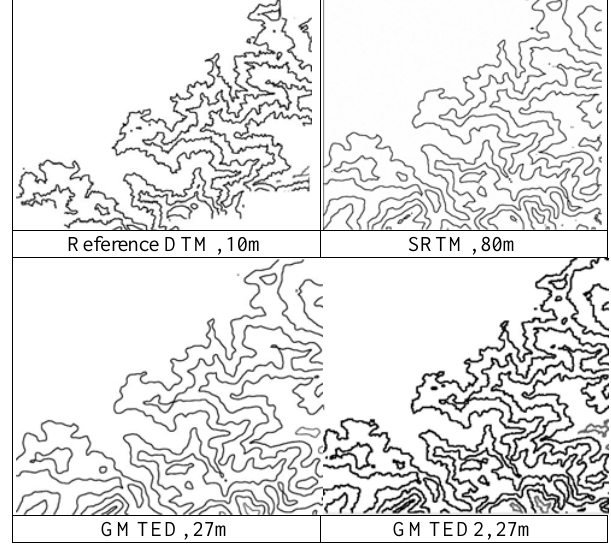
Figure 7: Contour lines based on different height models, with point spacing corresponding to actual latitude